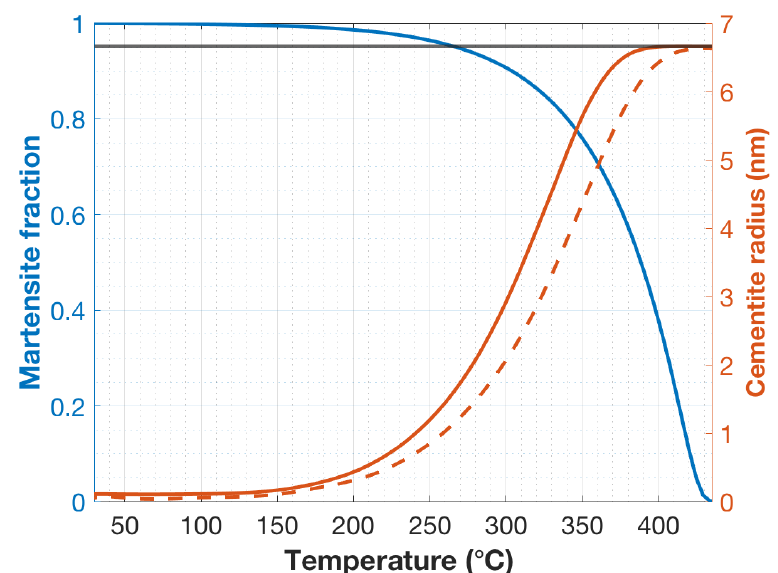
Figure 5. Martensite fraction vs. temperature, until room temperature, as shown with a blue line. The evolution was based on the Koistinen–Marburger equation in combination with electron probe microanalyses of local chemical compositions. The methodology is explained in Ramesh Babu et al. [13]. The predicted upper-bound radius of cementite precipitated in martensite laths formed at various temperatures through the quenching process is shown with orange lines. The solid orange line represents the radius of cementite near center of the specimen where the cooling rate was about 1000 ◦ C / s. The dashed orange line represents the radius of cementite formed near the edge of the specimen where the cooling rate was about 2000 ◦ C / s. The black line represents the predicted radius of cementite after the hot-mounting stage.